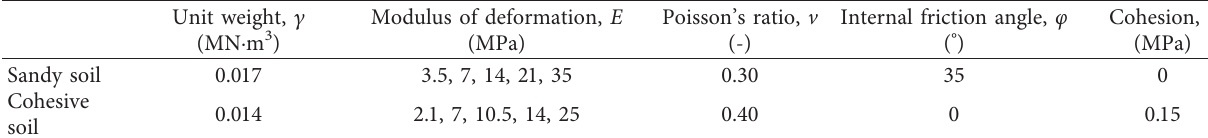
Figure 7: Numerical model in earth stepped-twin retaining wall by constructing with anchors and struts. (a) 1 strut. (b) 2 struts. (c) 3 struts. Table 5: Physical and mechanical properties of sandy soil and cohesive